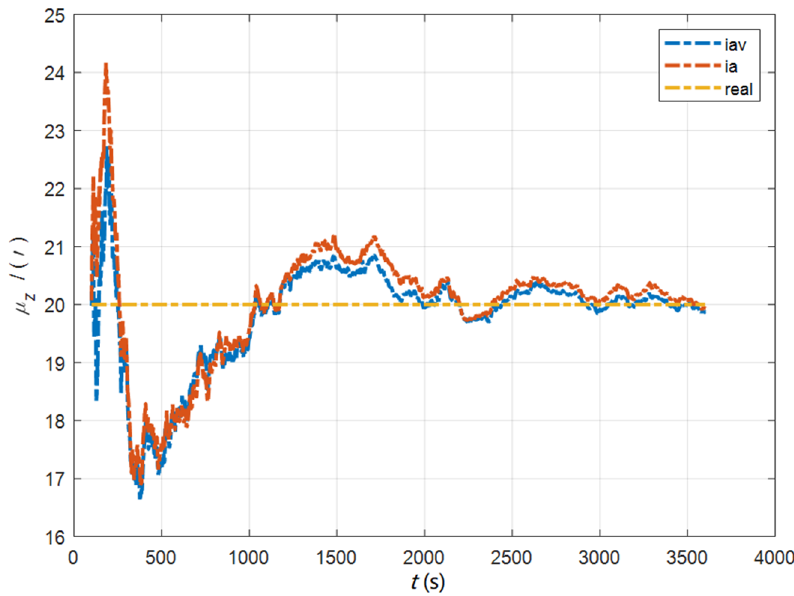
μ Figure 15. The curves of in the cases of the initial misalignment angles z ′ , the error curves of the μ Figure 15. The curves of µ z in the cases of the initial misalignment angles [ 0.5 (cid:48) 0.5 (cid:48) 10 (cid:48) ] T . Figure 15. The curves of in the cases of the initial misalignment angles z ′ In the cases of the initial misalignment angles , the error curves of the γ dynamic deflection deformation angle are shown in Figures 16–18.